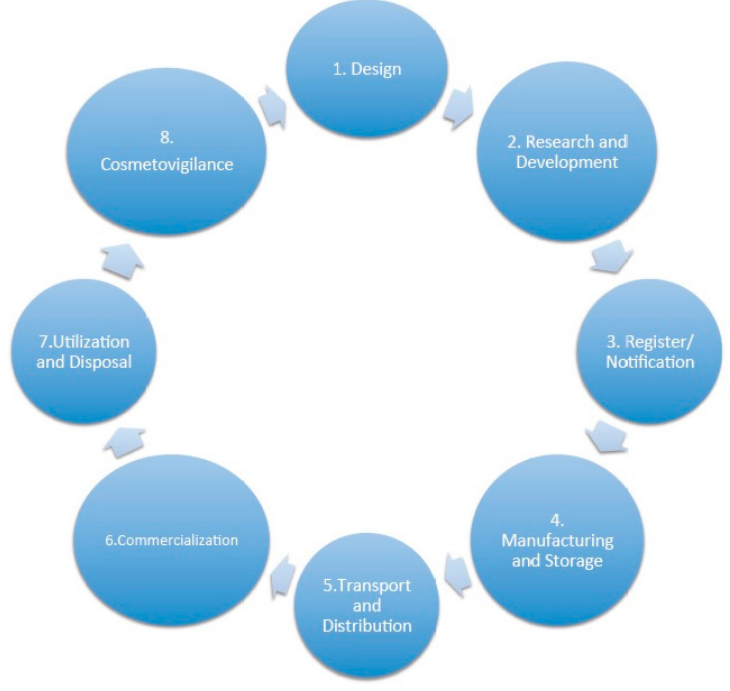
Figure 1. Lifecycle of a cosmetic product.